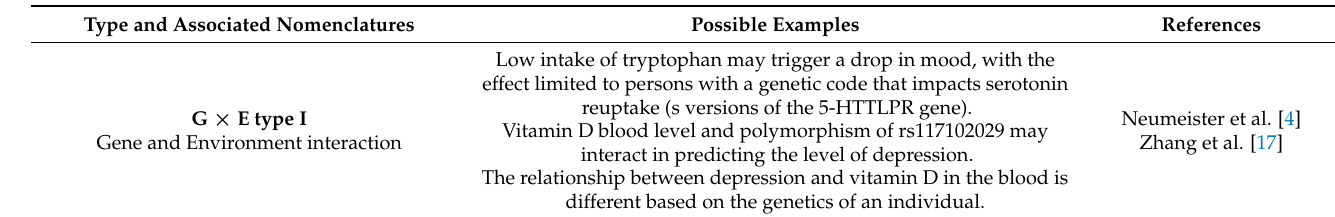
Table 1. Three Ways Nature and Nurture are Not Separate